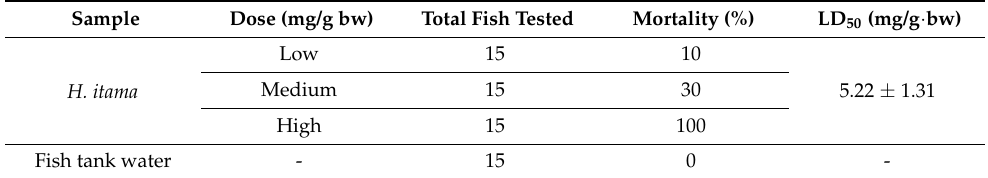
Table 4. The prolong-acute toxicity test of pure H. itama honey in adult zebrafish ( Danio rerio ).